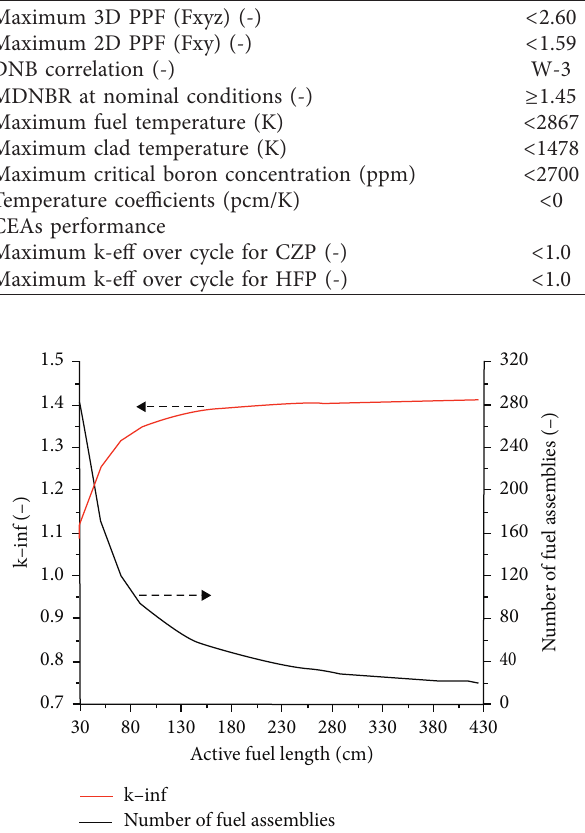
Figure 2: Variation of the infinite multiplication factor and re- quired number of assemblies with increasing active fuel length.